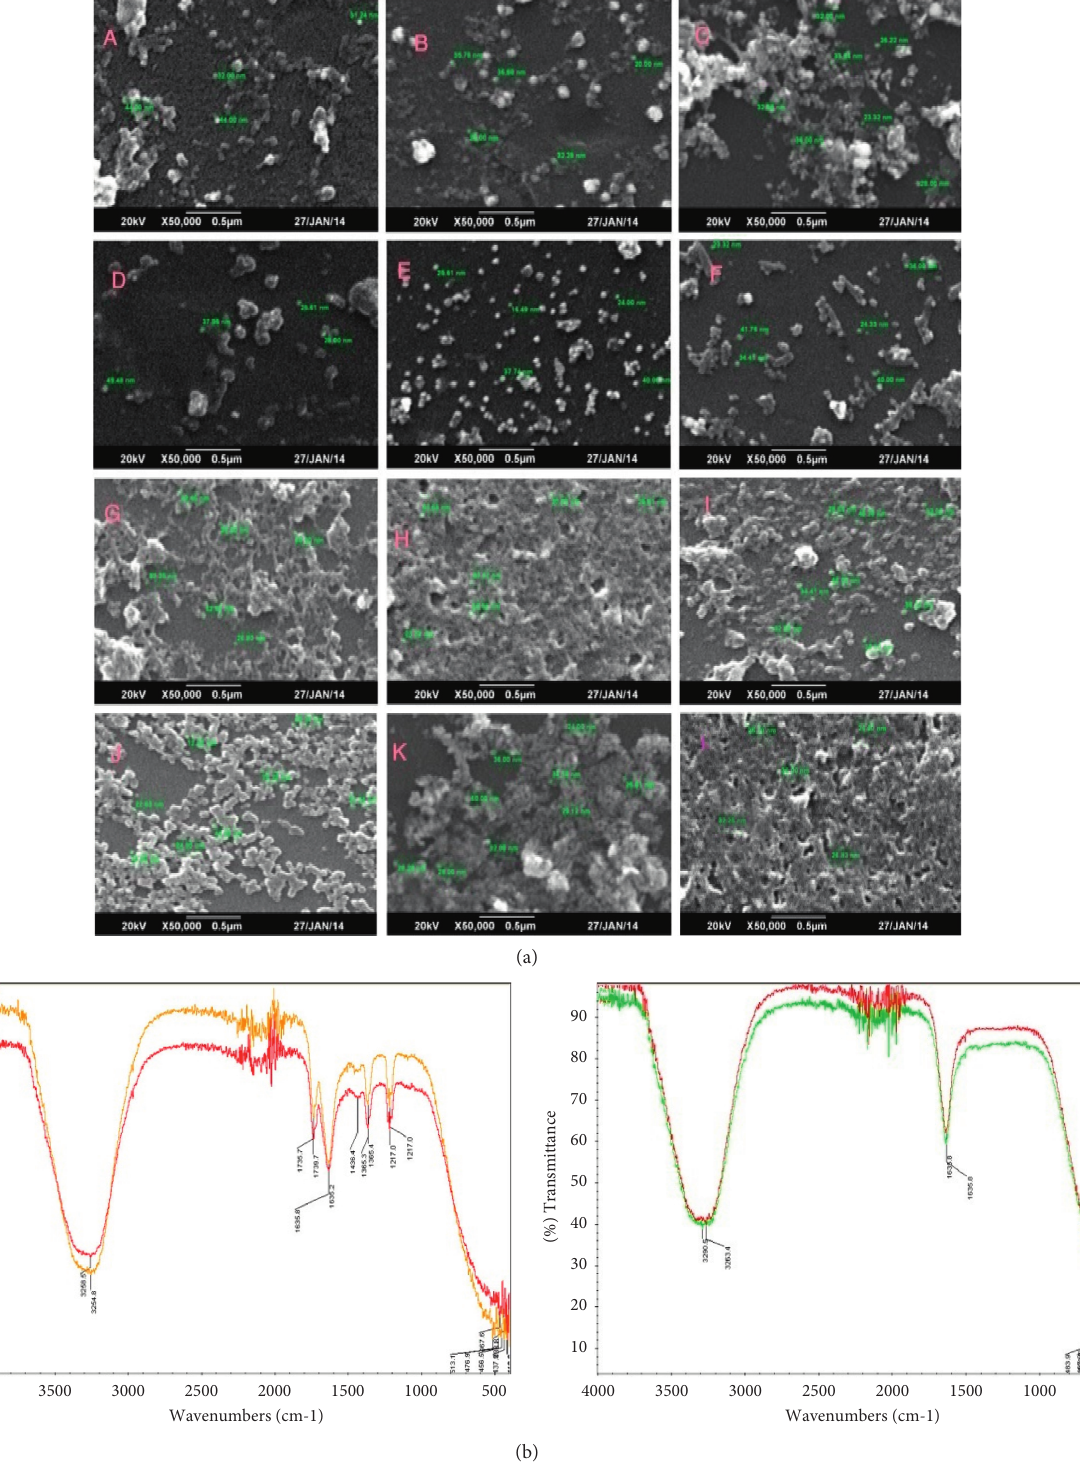
Figure 2: (a) SEM images of (A) P. emblica AuNPs, (B) S. cumini AuNPs, (C) M. piperita AuNPs, (D) R. indica AuNPs, (E) M. philippensis AuNPs, (F) F. microcarpa AuNPs, (G) P. emblica FeNPs, (H) S. cumini FeNPs, (I) M. piperita FeNPs, (J) R. indica FeNPs, (K) M. philippensis FeNPs, (L) F. microcarpa FeNPs. (b) FTIR spectra of (A) S. cumini AuNPs and S. cumini extract, (B) F. microcarpa AuNPs and F. microcarpa